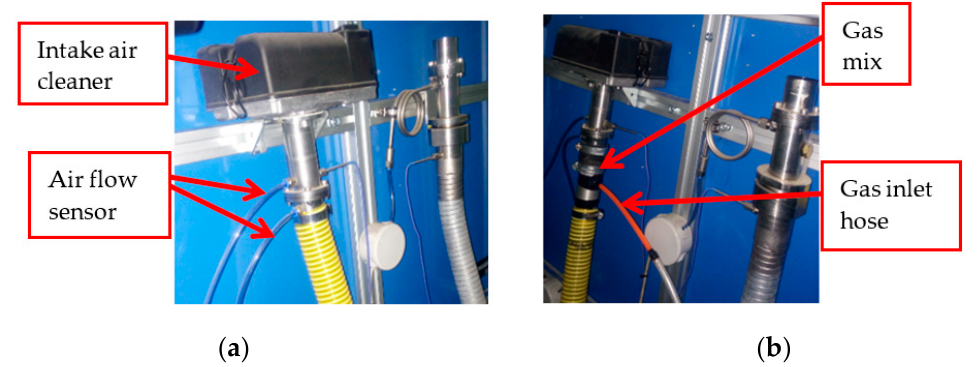
Figure 1. Installation of venturi gas mixer at the air intake manifold. ( a ) Before installing gas mixer, ( b ) after installing a gas mixer. ( b ) after installing a gas